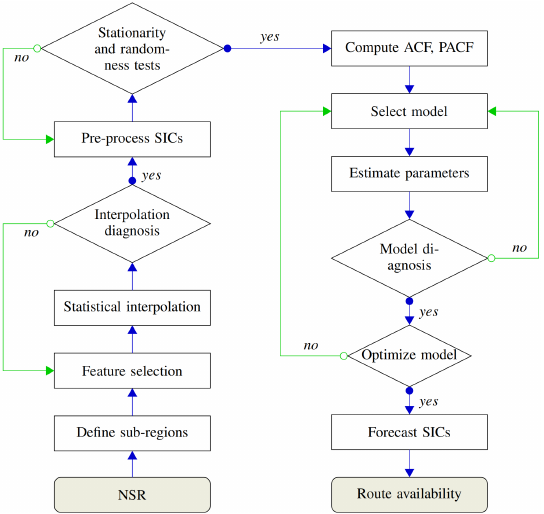
Figure 3. The workflow for implementing the statistical interpolation and ARIMA model for evaluat- ing the route